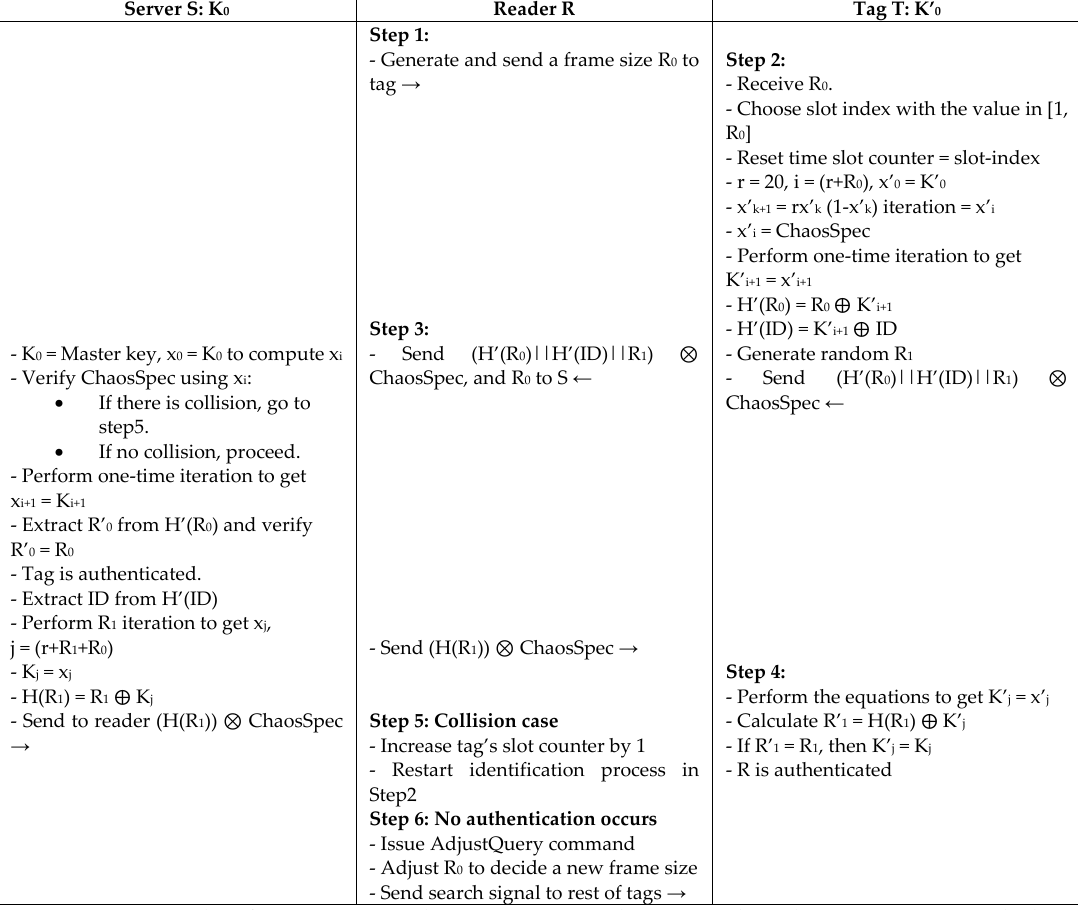
Figure 17. Anti-Collision Security Protocol (ACS) by Keqiang.